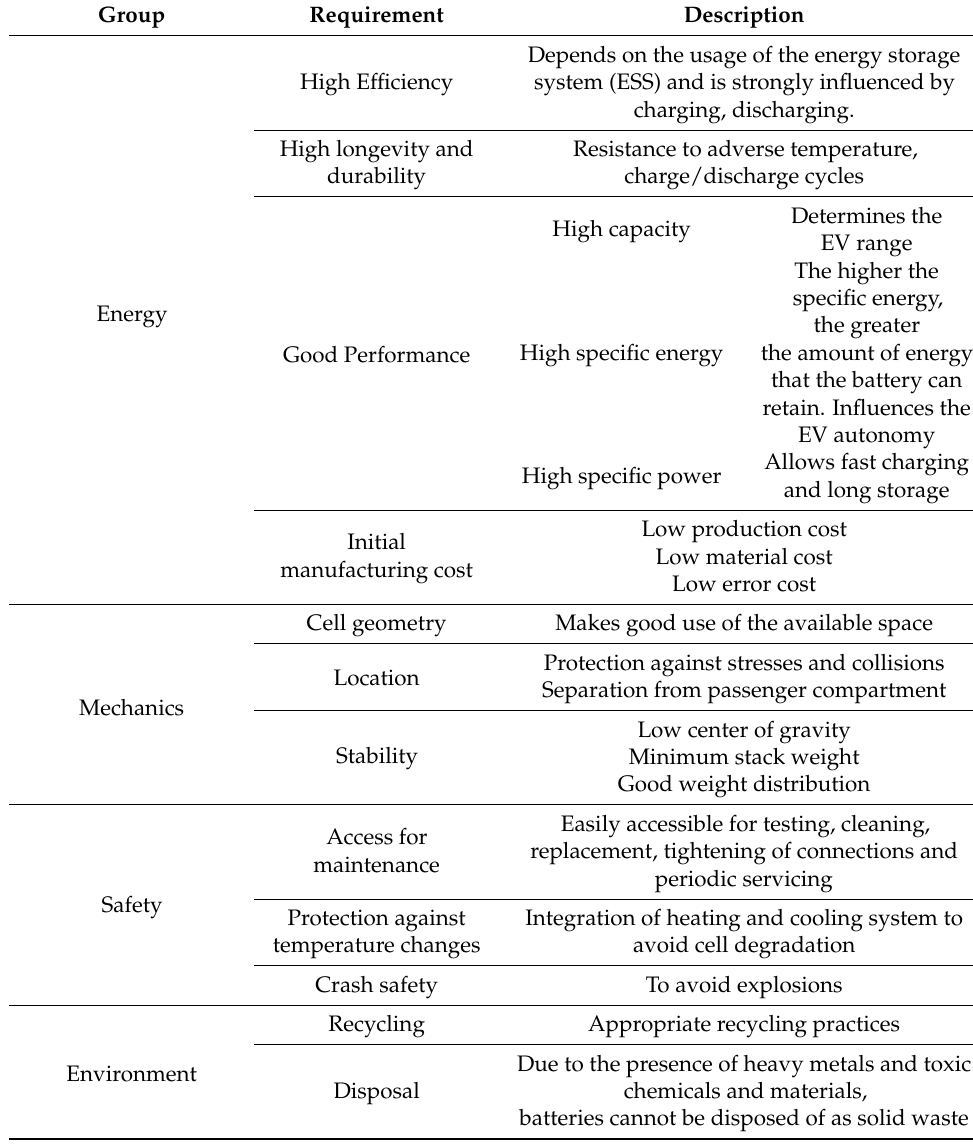
Table 1. Battery requirements matrix for electric vehicle chassis integration